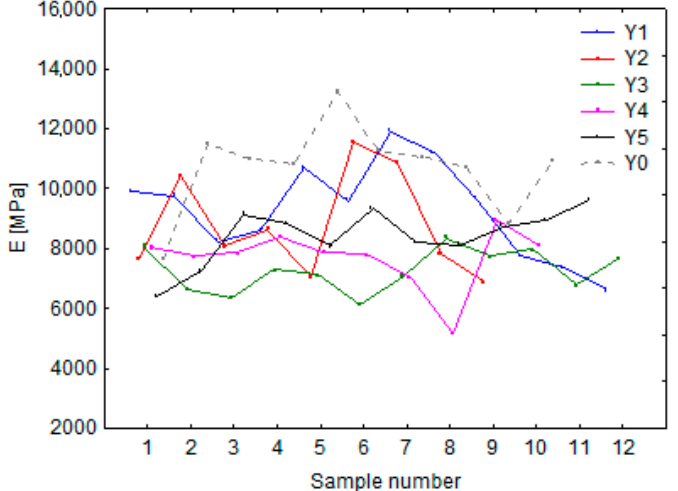
Figure 6. The radial variability of modulus of elasticity (MOE) of spruce wood depending on the period of time since the tree’s decay.